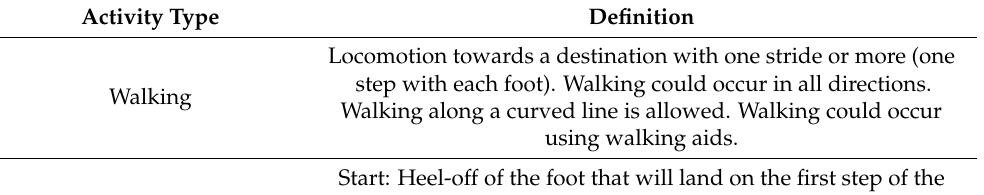
Table 2. The activity type definitions during video